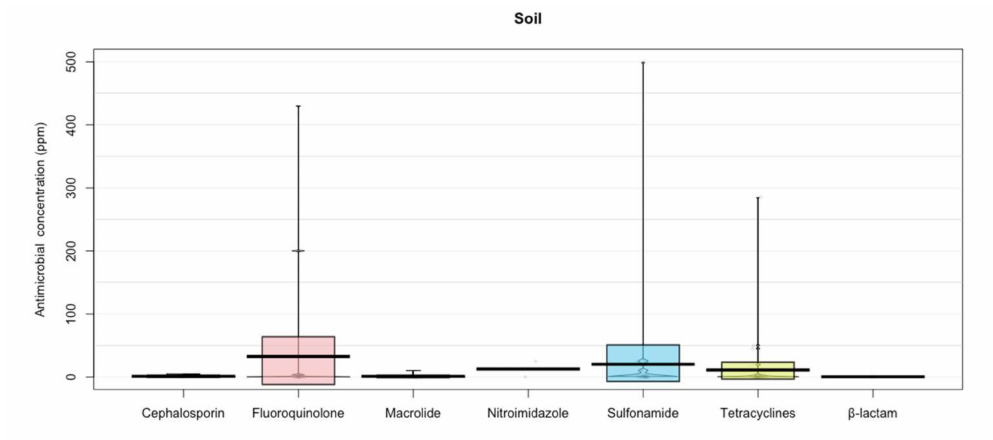
Figure 6. Antibiotic residues in soil. Points represent the raw data; bar/line is the descriptive statistic (mean); bean is the smoothed density curve showing the full data distribution; and brackets represent the confidence